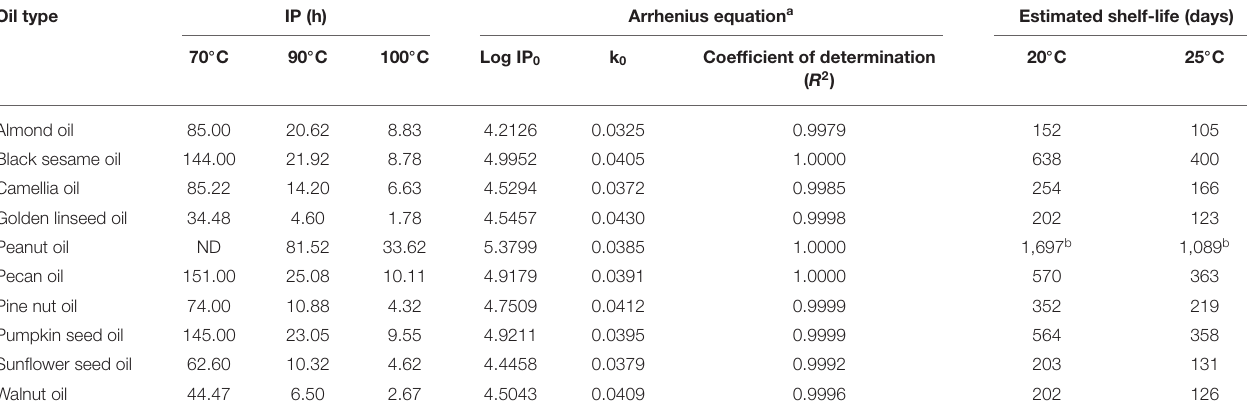
TABLE 4 | Induction periods (IPs), Arrhenius equations, and estimated shelf-lives of 10 expeller-pressed oils by the OXITEST method. Oil type